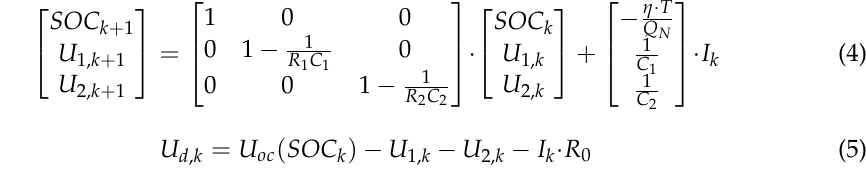
(6) Rebound voltage is the value of electrode potential deviation from equilibrium po- tential caused by equivalent impedance in the charging and discharging process of the battery, which mainly includes ohmic internal resistance and polarization internal re- sistance. The analysis of battery rebound voltage characteristics can provide a basis for the estimation of basic model parameters. Figure 3 shows the single-stage discharge cur- rent and voltage. As shown in segments A-B in Figure 3b, the voltage is dropped sharply at the beginning of discharge and then slowly decreased to point B. At the end of dis- charge, as shown in segments B-C-D, the voltage is rapidly raised and then increased slowly.